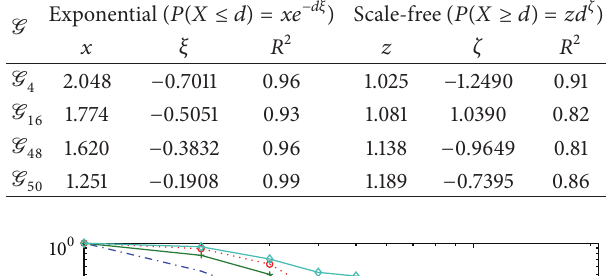
Table 1: Test power grids components, number of nodes 𝑁 , and transmission lines 𝑙 comprising each grid are presented.